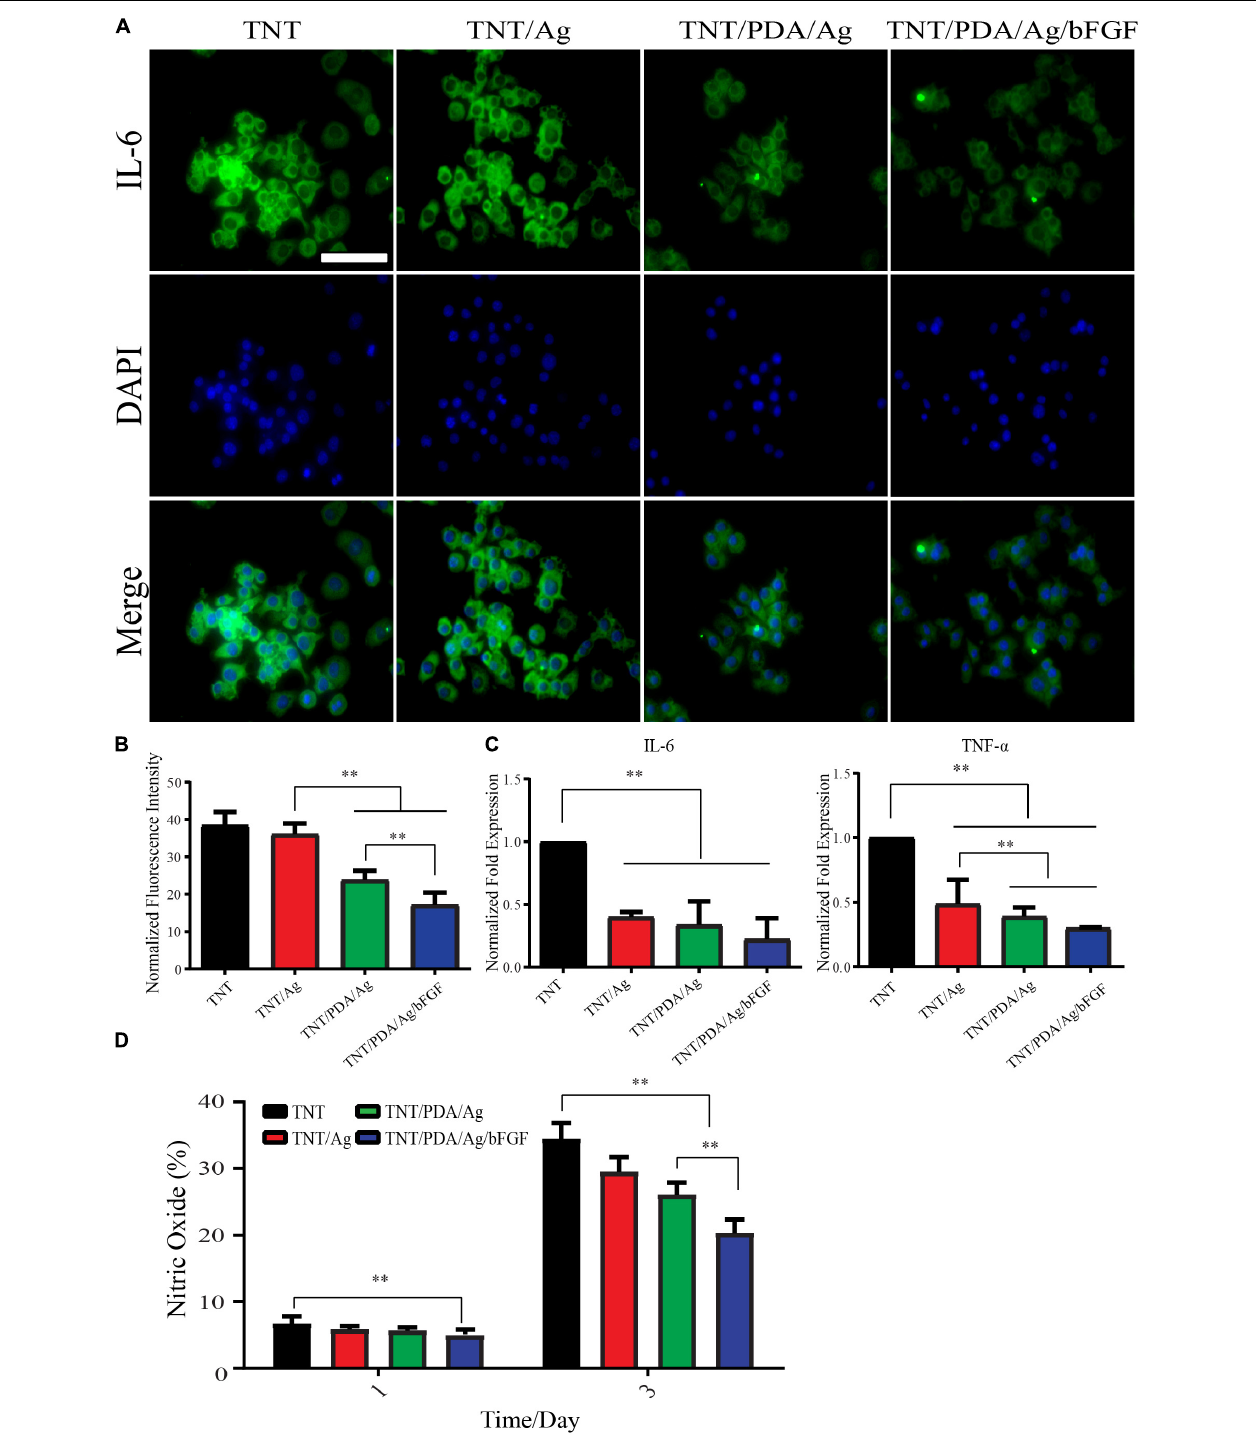
FIGURE 9 | Anti-inflammatory property of modified Ti samples on RAW 264.7 stimulated by lipopolysaccharide (LPS) (500 ng/ml). (A,B) LPS exposure of 12 h resulted in elevated expression of IL-6 in macrophages significantly. The expression of IL-6 decreased in the order of TNT, TNT/Ag, TNT/PDA/Ag, and TNT/PDA/Ag/bFGF. Scale bar represents 20 µ m. (C) After 12 h LPS exposure of RAW 264.7, a significant reduction in gene expression of IL-6 and TNF- α was observed on TNT/Ag, TNT/PDA/Ag, and TNT/PDA/Ag/bFGF. (D) To quantify the level of nitric oxide, RAW 264.7 was seeded on sample surfaces with LPS for 1 and 3 days. It was found that TNT/PDA/Ag/bFGF had a good anti-inflammatory effect and decreased nitric oxide production on RAW 264.7. Data are presented as mean ± standard deviation; ∗∗ p < 0.01.